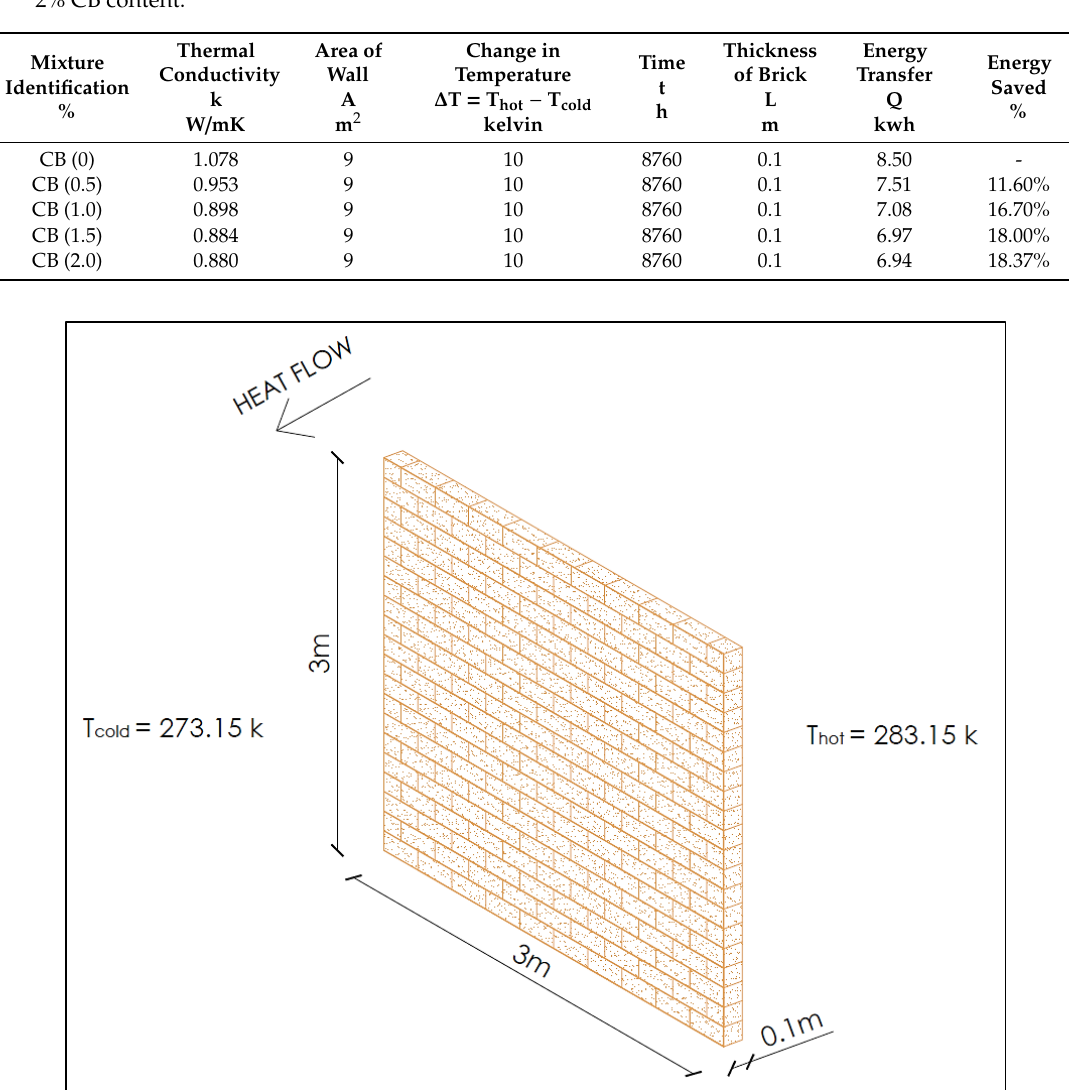
Figure 18. Fired clay brick wall.